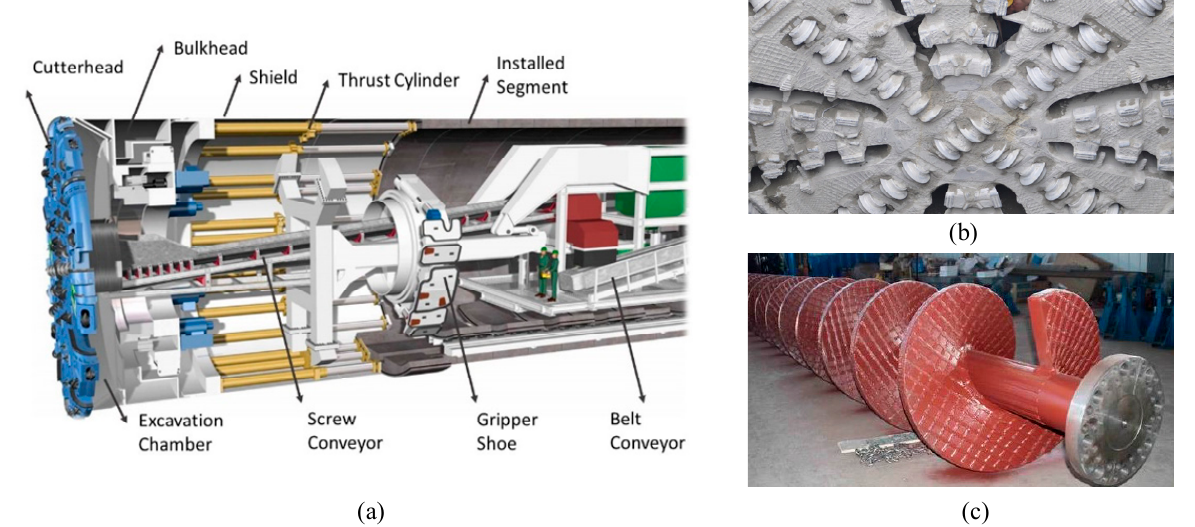
Figure 4. Illustration of EPB-TBM for ( a ) key components in the TBM, ( b ) photo of the cutter head panel, and ( c ) photo of the screw conveyor. Table 4. The remaining thickness for the wear-resistance structure on the cutter head panel. Zone